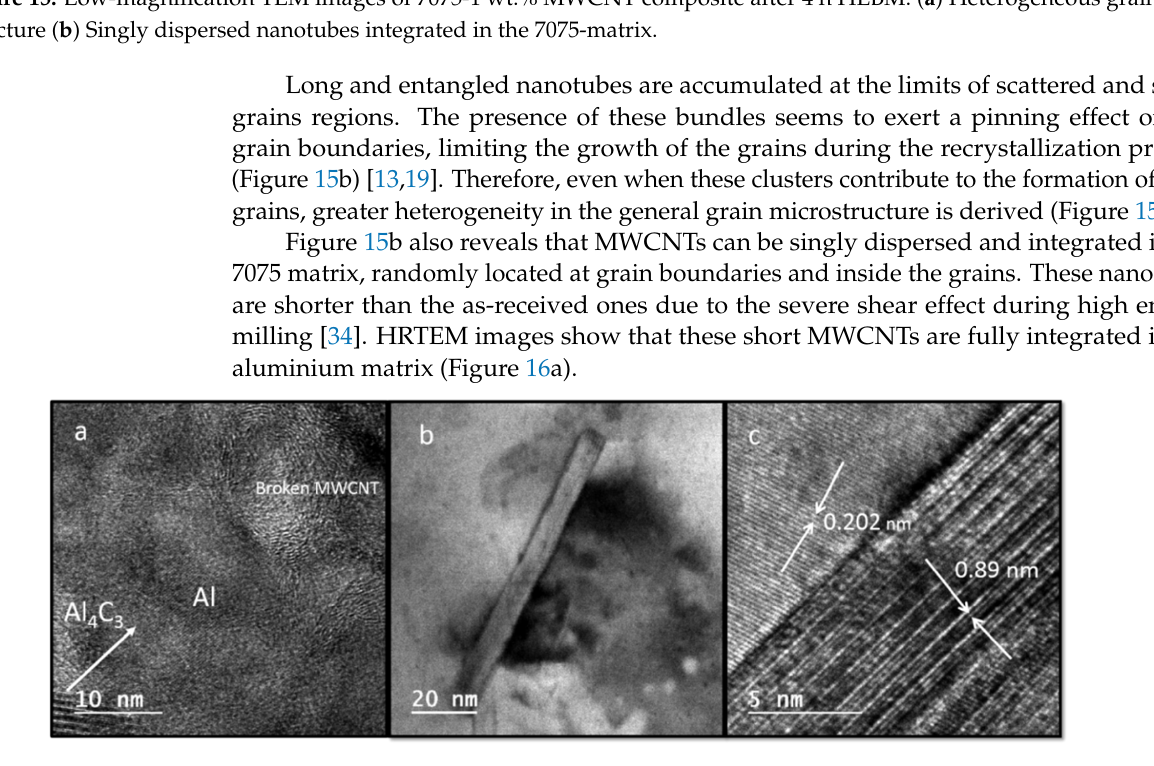
Figure 15. Low-magnification TEM images of 7075-1 wt.% MWCNT composite after 4 h HEBM. ( a ) Heterogeneous grain structure ( b ) Singly dispersed nanotubes integrated in the 7075-matrix.